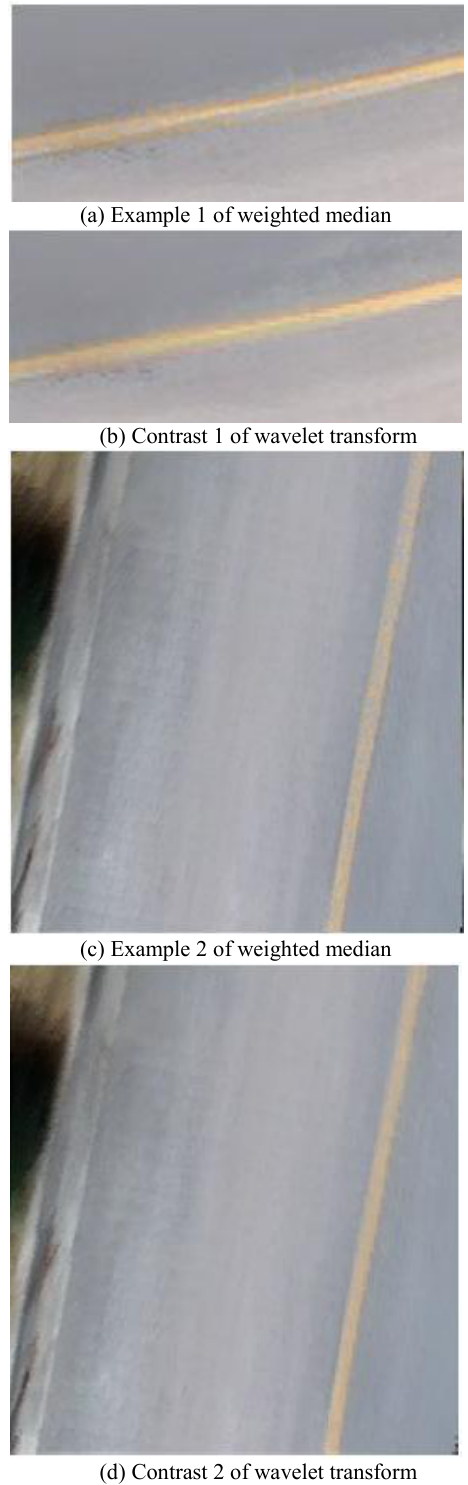
Fig.7. result of wavelet transform map fusion and the contrast of weighted median map